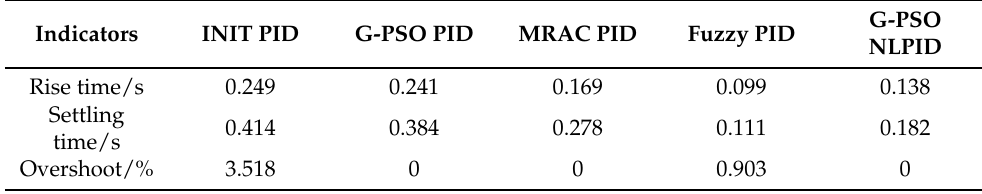
Figure 8. Simulation response curves of different controllers: ( a ) Comparison of PID and NLPID controllers based on G-PSO algorithm, ( b ) Comparison of G-PSO NLPID, Fuzzy PID, and MRAC PID. Table 5. Detailed performance indicators of different